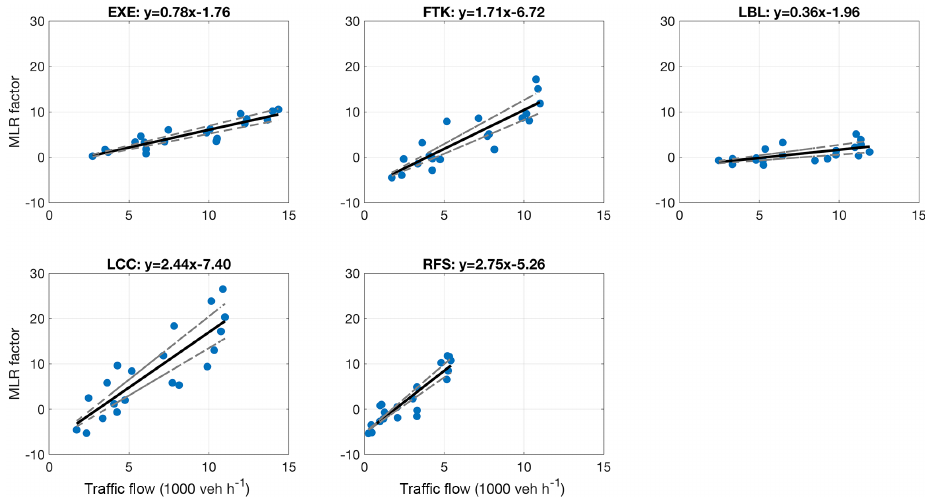
Figure 10. Morning (04:00–08:00LT) multiple-linear-regression coefficients shown as a function of summertime traffic flow; black solid lines indicate the linear regression through the MLR factors (equations given above each subplot), and gray dashed lines show the uncertainty in the regression